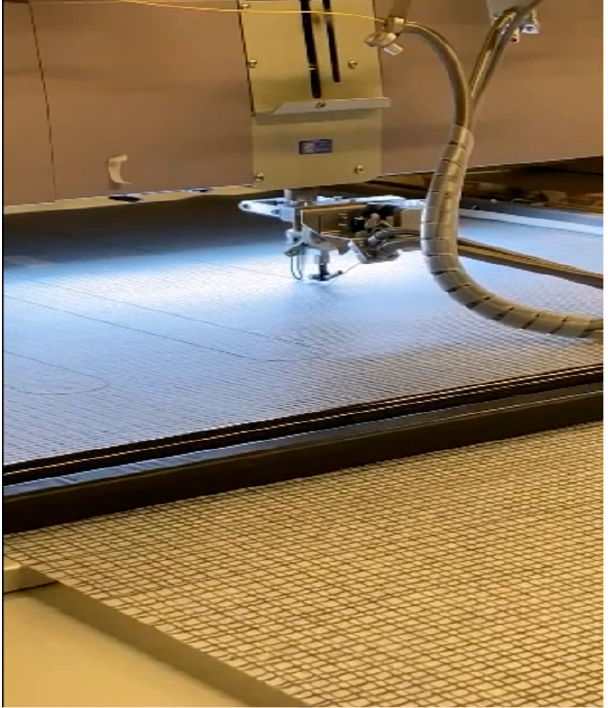
Figure 2. Picture of an embroidery machine embedding a fiber sensor into a textile.